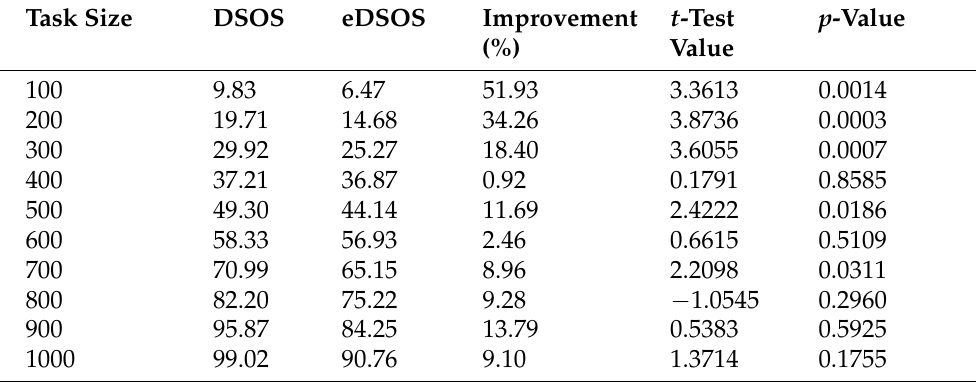
Table 11. Comparison of the response times of DSOS and eDSOS for the dataset with the right-half distribution.